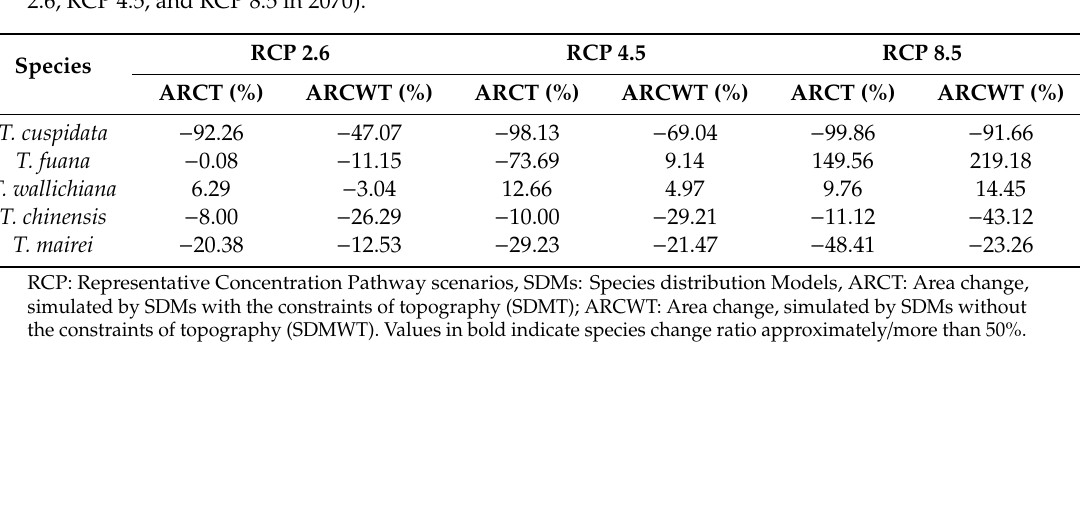
Figure 3. Binary distribution maps for T. fuana under current and future (RCP 2.6, RCP 4.5, and RCP 8.5 in 2070) environmental conditions, simulated by SDMs with the constraints of topography.